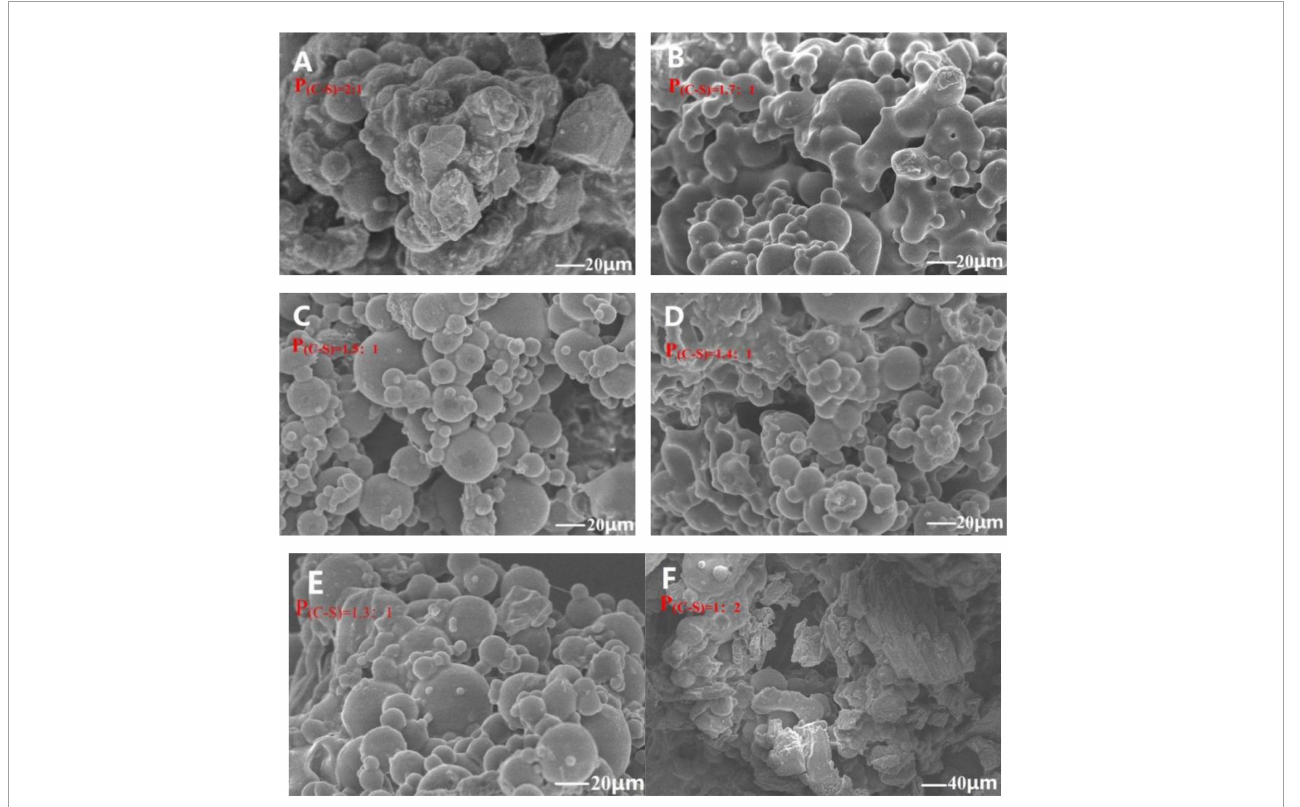
FIGURE1 Microstructure of Perilla essential oil microcapsules (PEOM) with different core-shell ratio [P ( C - S ) = 2 : 1 (A) , P ( C - S ) = 1 . 7 : 1 (B) , P ( C - S ) = 1 . 5 : 1 (C) , P ( C - S ) = 1 . 4 : 1 (D) , P ( C - S ) = 1 . 3 : 1 (E) , P ( C - S ) = 1 : 2 (F) , Supplementary Figure 3 ] [For example, P ( C − S ) = 2 : 1 indicated core-shell ratio was